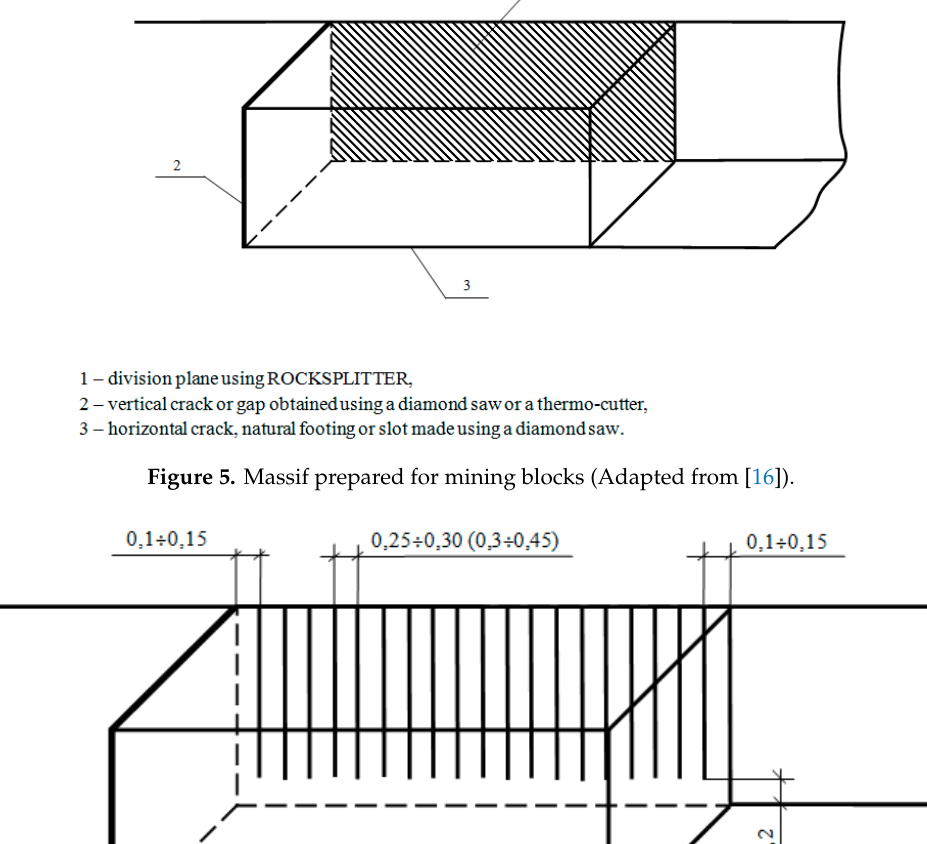
Figure 5. Massif prepared for mining blocks (Adapted from [16]).